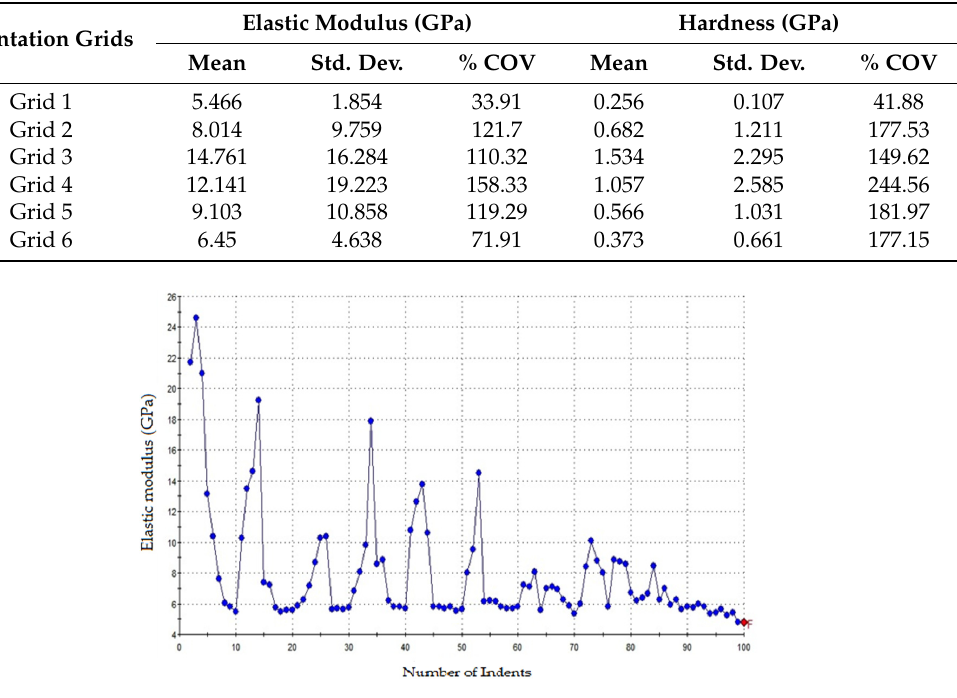
Table 3. Nanomechanical properties of coatings.